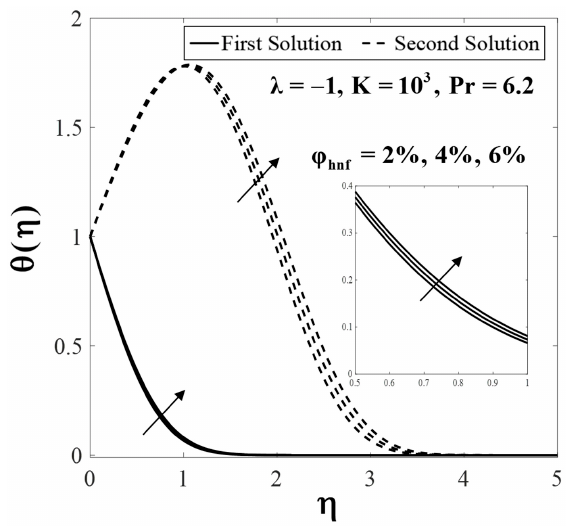
Figure 7. Temperature profiles θ ( η ) for different values of ϕ hnf Furthermore, the dimensionless stream function is plotted to show the flow patterns. In this respect, the streamlines of the first and the second solutions for the opposing flow ( 𝜆 = −2 ) when 𝜑 (cid:3035)(cid:3041)(cid:3033) = 2% , 𝐾 = 10 (cid:2871) , and Pr = 6.2 are shown in Figures 8 and 9, respec- tively. The flow patterns for the first solution show that the fluid is moving away from the slot ( 𝑥 = 0 ) and acts as the normal stagnation point flow. Meanwhile, the flow is split into two regions for the second solution, i.e., upper and lower regions. The upper region has similar pattern with that of the first solution, whereas reverse flow is observed in the lower region. The variations of the smallest eigenvalues 𝛾 against the mixed convection parameter 𝜆 when 𝜑 (cid:3035)(cid:3041)(cid:3033) = 2%,Pr = 6.2 , and 𝐾 = 10 (cid:2871) are described in Figure 10. For the positive value of 𝛾 , it is noted that 𝑒 (cid:2879) (cid:3082)(cid:3099) → 0 as time evolves (𝜏 → ∞) . In the meantime, for the negative value of 𝛾 , 𝑒 (cid:2879) (cid:3082)(cid:3099) → ∞ . These behaviors show that the first solution is physically reliable and stable over time.